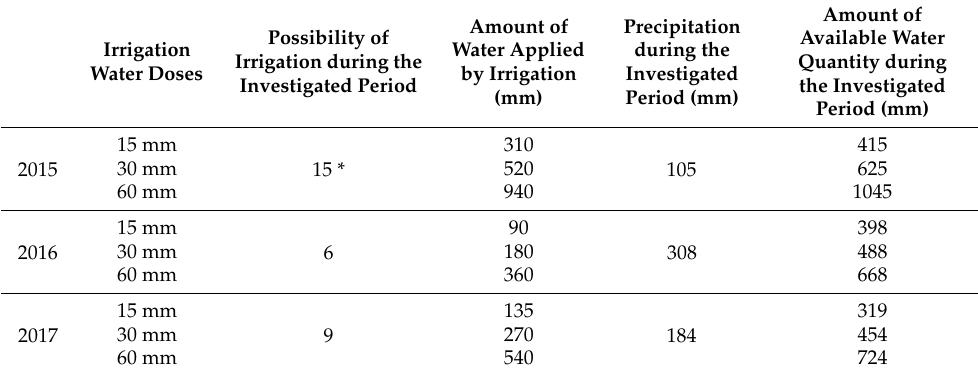
Table 2. The amount of irrigation water applied per year and distribution of precipitation during studied vegetation period.